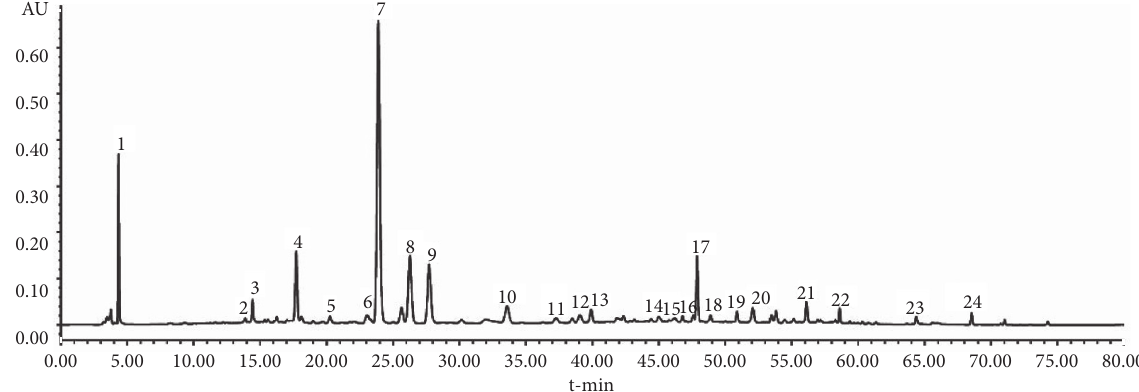
Figure 2: The HPLC fingerprint of YYTN.